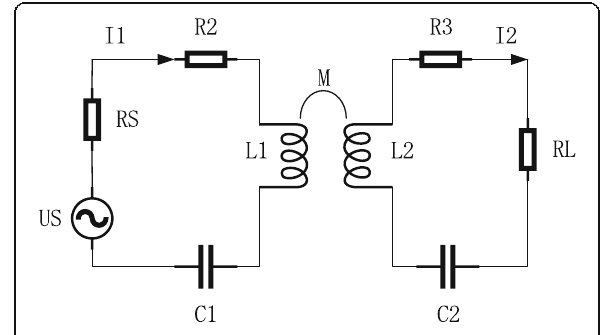
Fig. 4 Simplified circuit with S-S